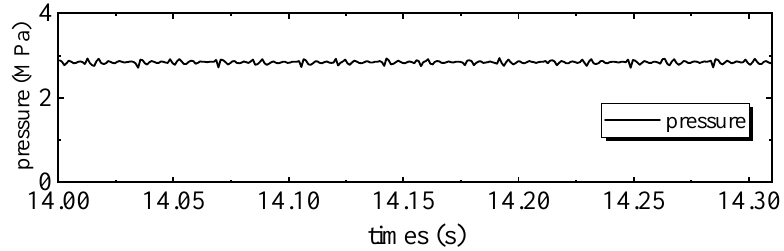
Figure 6. Load pressure of the linear drive collaborative rectification structure pump of PID.